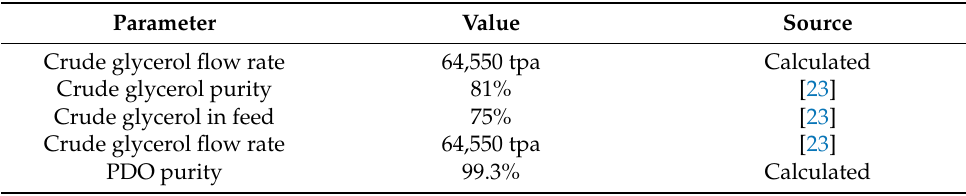
Table 4. Specifications for mass balances and conversions in Area